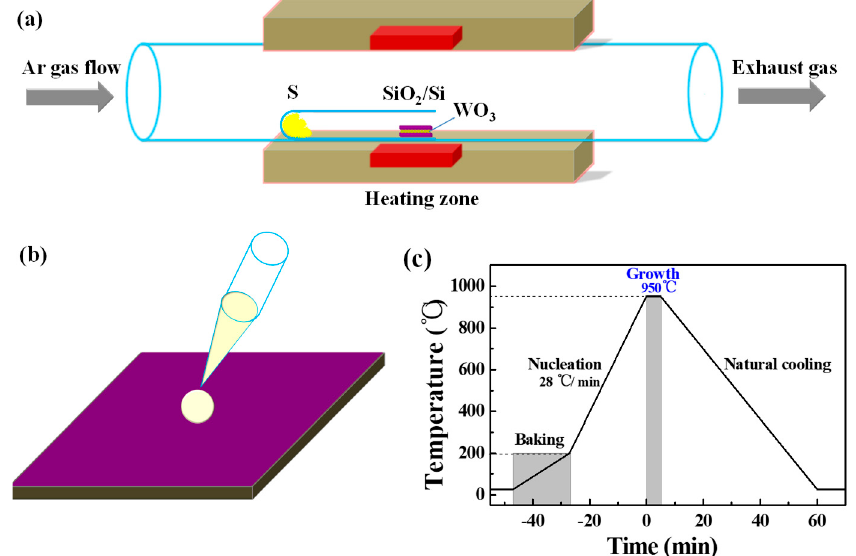
Figure 1. ( a ) Schematic diagram of the horizontal single-zone furnace employed for the synthesis of WS 2 on SiO 2 /Si substrates. ( b ) Schematic illustration for the drop-casting of WO 3 -ethanol suspension solution onto the SiO 2 /Si substrate. ( c ) Temperature profile adopted for the synthesis of WS 2 flakes at 950 ° C for 5 min.